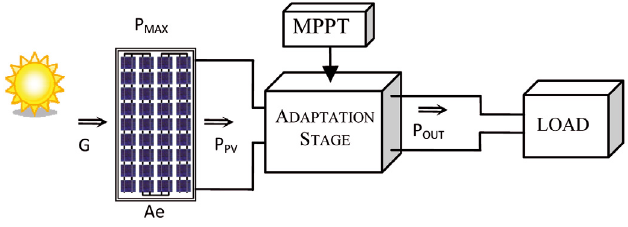
Fig. 1. Elementary photovoltaic conversion chain.